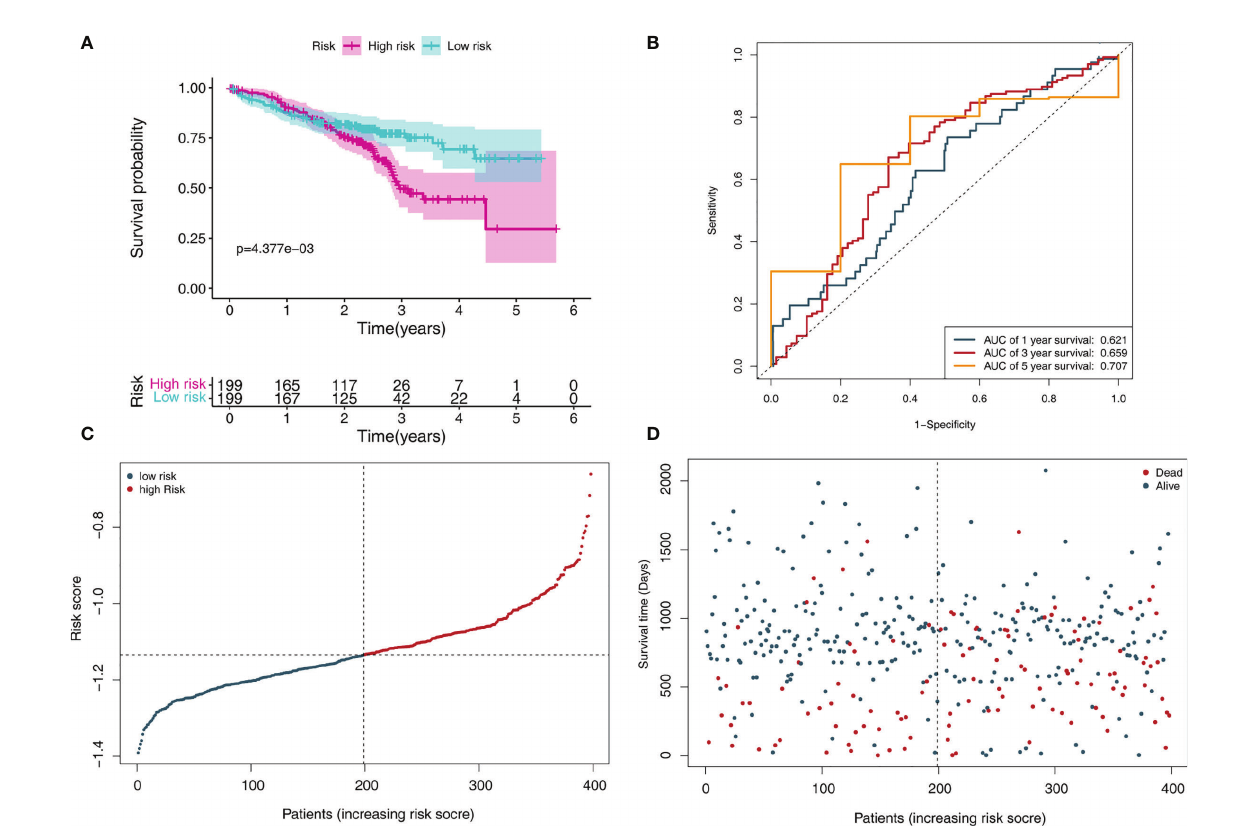
FIGURE 5 | MRGs-based risk signature evaluation using the testing set (GSE72094). (A) Kaplan-Meier survival analysis revealed the difference in survival rate between high- and low-risk patients. (B) Time-dependent ROC curve analysis for 1-, 3-, and 5-year predictions of overall survival using the MRG-based signature. (C) Risk score distribution of patients with the overall survival and signature. (D) Overall survival scatter plots for LADC